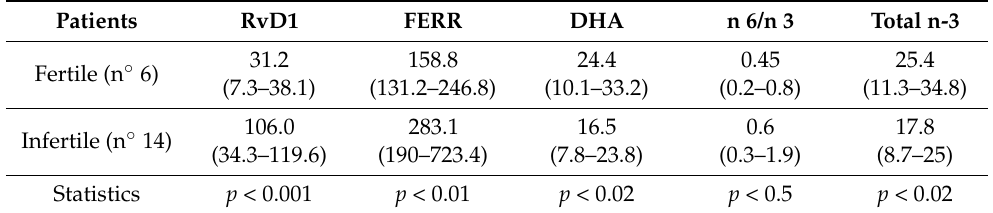
Table 5. Median and Interquartile ranges (IQR) of RvD1, FERR, DHA, n6/n3, and total n-3 in fertile and infertile individuals. Legends: RvD1: resolvin D1 pg/mL; FERR, ferritin; DHA,